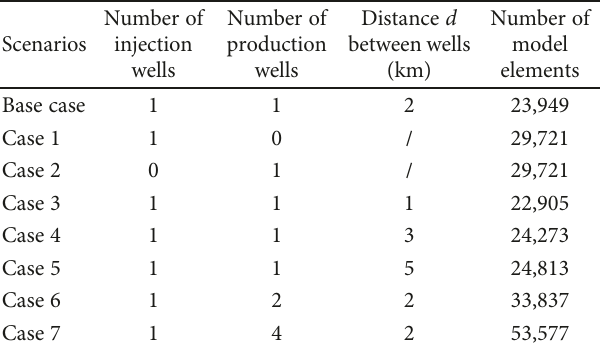
Figure 2: Porosity and permeability of the reservoir formations according to borehole logging data. Table 1: Detailed information of di ff erent simulation